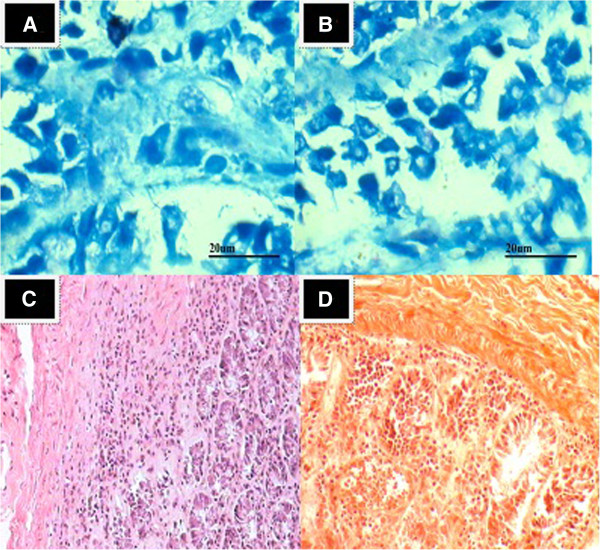
Colonic biopsies of Helicobacter spp. in the stray dogs. (A and B). Colonic biopsies: Moderate to severe amount of Helicobacter spp in the superficial mucus entering a colonic crypt (Wright Giemsa staining) C and D: Lymphoplasmacytic and neutrophilic infiltration (hematoxylin and eosin; 400×).